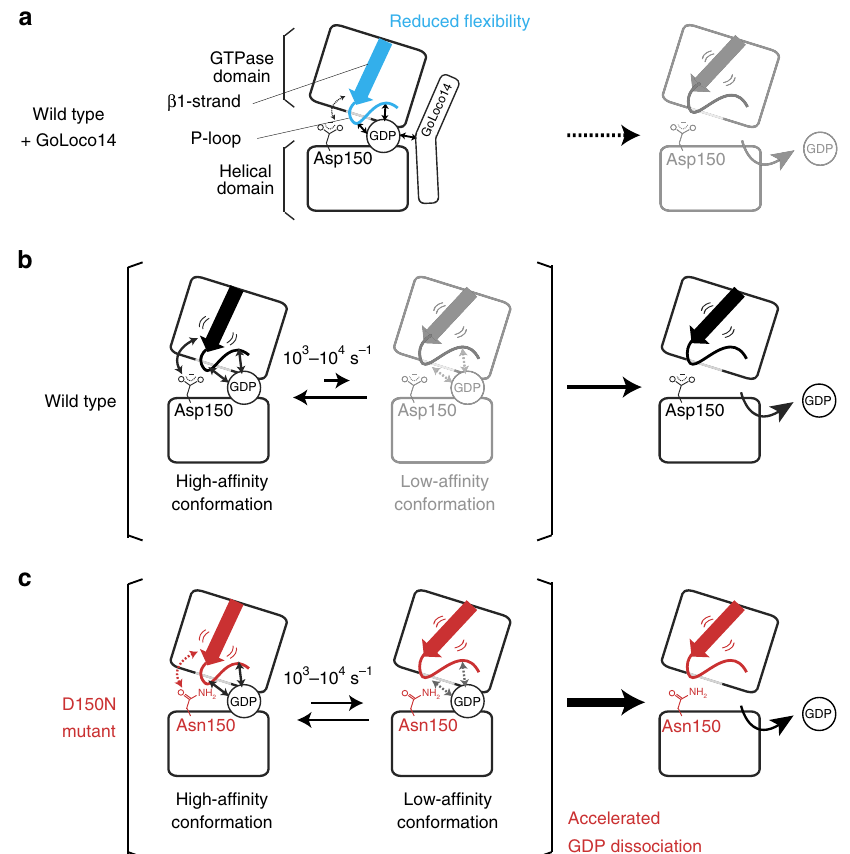
Figure 6 | Schematic representation of the conformational equilibrium in G a -GDP and the regulation of the GDP dissociation. ( a ) The binding of GoLoco14 suppresses the conformational exchange processes and stabilizes the ground-state conformation that tightly binds to GDP, leading to the inhibition of the GDP dissociation. ( b ) The b 1-strand and P-loop regions exist in an equilibrium between conformations with high and low affinity to GDP. The low-affinity conformation promotes the GDP dissociation. ( c ) The conformational equilibrium shifts towards the low-affinity conformation in the D150N mutant, causing the accelerated GDP